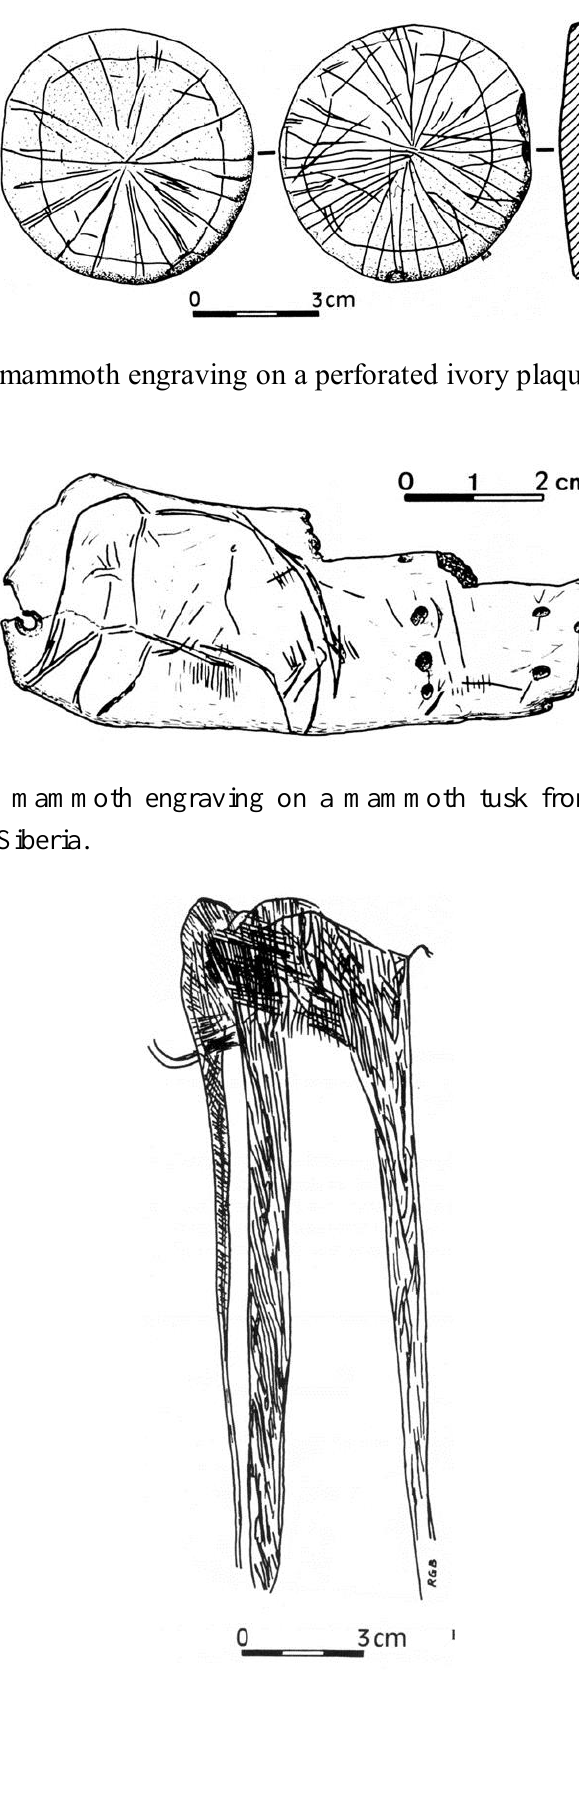
Figure 6. Both sides and section of engraved ivory disc from Afontova Gora III, western- central Siberia.